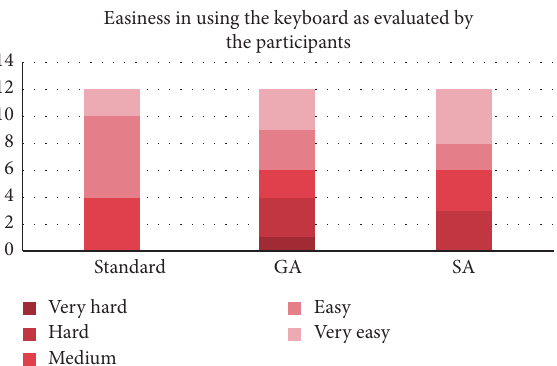
Figure 12: The usability as evaluated by the